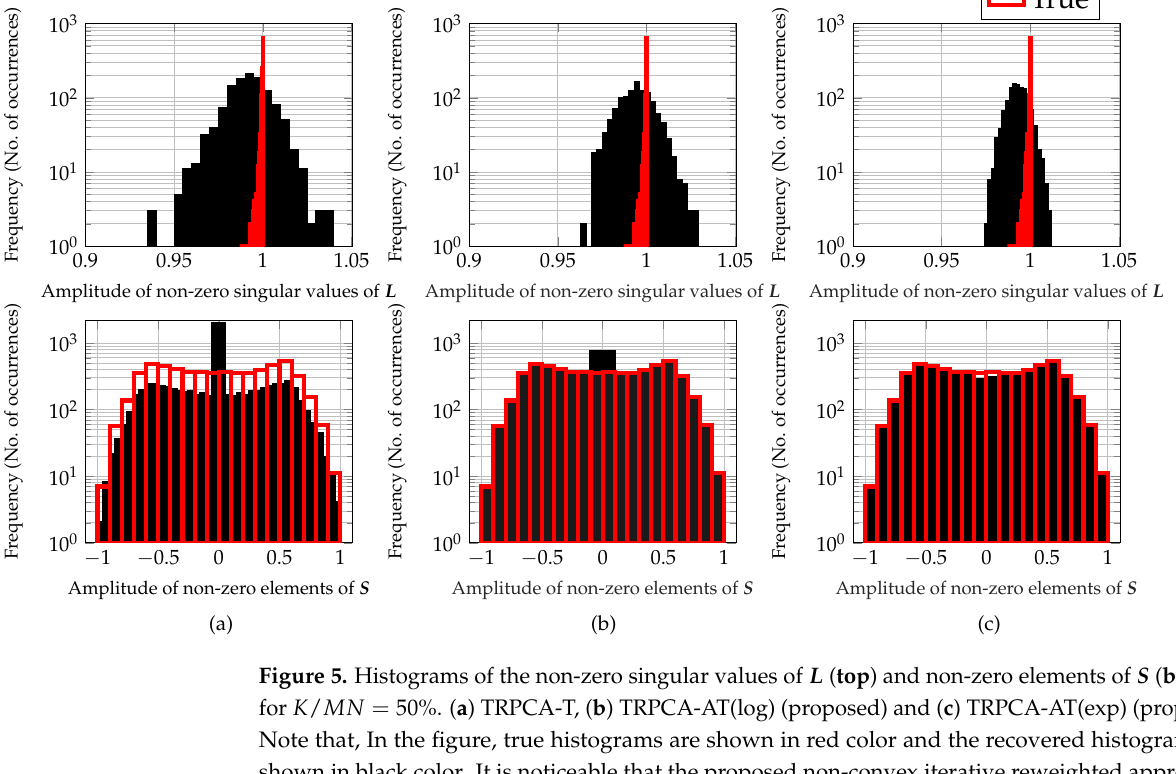
Figure 5. Histograms of the non-zero singular values of L ( top ) and non-zero elements of S ( bottom ) for K / MN = 50%. ( a ) TRPCA-T, ( b ) TRPCA-AT(log) (proposed) and ( c ) TRPCA-AT(exp) (proposed). Note that, In the figure, true histograms are shown in red color and the recovered histograms are shown in black color. It is noticeable that the proposed non-convex iterative reweighted approaches (TRPCA-AT(exp) and TRPCA-AT(log)) closely follow the histograms of the true non-zero elements of S and non-zero singular values of L compared to the unweighted approach TRPCA-T. In addition, the recovered S by the unweighted approach TRPCA-T has many small values compared to the iterative reweighted approaches, i.e., the iterative reweighted approach achieves a more sparse solution than the unweighted